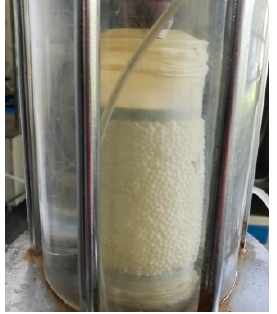
Figure 9. Glass bead specimen in triaxial test.